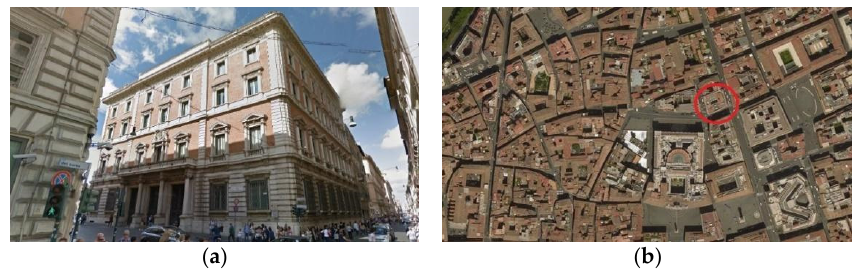
Figure 1. ( a ) Rome historic centre and case study building detail; ( b ) building view.